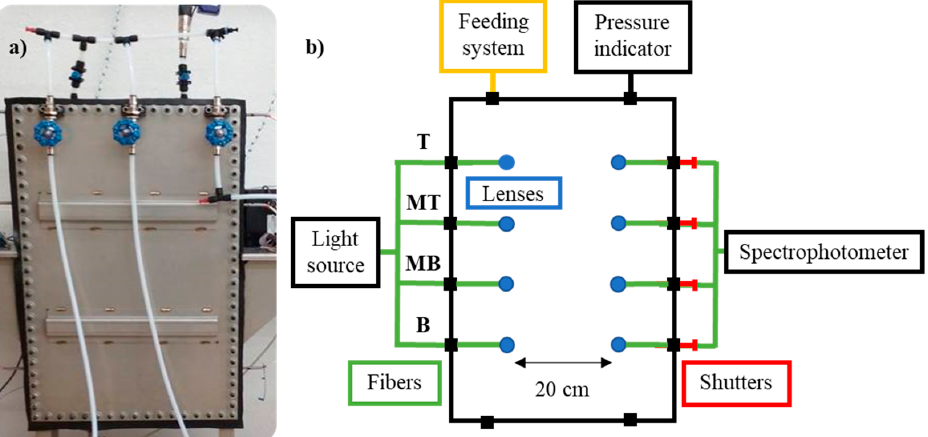
Figure 2. ( a ) Gas chamber and ( b ) scheme of the experimental equipment used for the gas diffusion study and its components. T (Top), MT (Medium Top), MB (Medium Bottom), and B (Bottom) correspond to the different heights of the measurement lines.